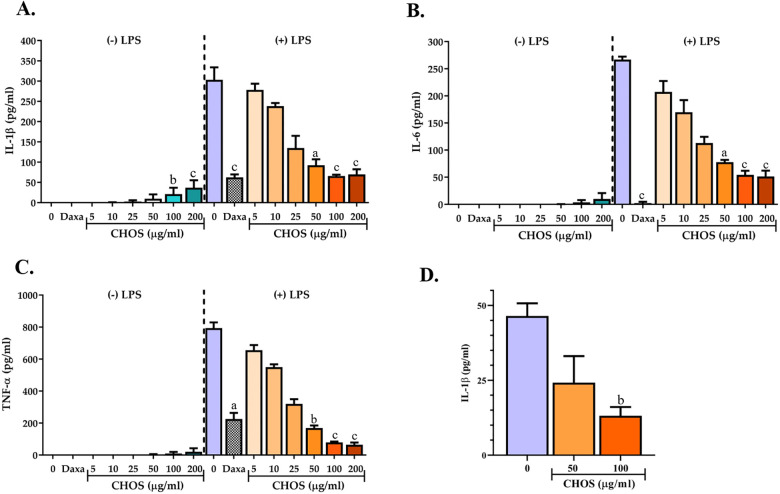
Dose-repose effects for the in vitro anti-inflammatory activity of soluble CHOS on human THP-1-derived monocytes.The effects of CHOS, at final concentrations ranging from 0 to 200 μg/mL, on release of IL-1β (A), IL-6 (B), and TNF-α (C) by LPS-stimulated, VitD3-differentiated THP-1 cells were determined by ELISA. Dexamethasone (0.5 μM), a standard anti-inflammatory drug, was used as a positive control. (D) An extra washing step was done after CHOS treatment before LPS challenging. The shown data are from three independent duplicated experiments (n = 6) except Fig 6D, which reflects one triplicated experiment (n = 3). Significance levels: a = P < 0.001, b = P < 0.01, c = P < 0.05 (compared with 0 μg/mL CHOS). See S1 Fig for an enlargement of data from the experiments without LPS stimulation (-LPS).